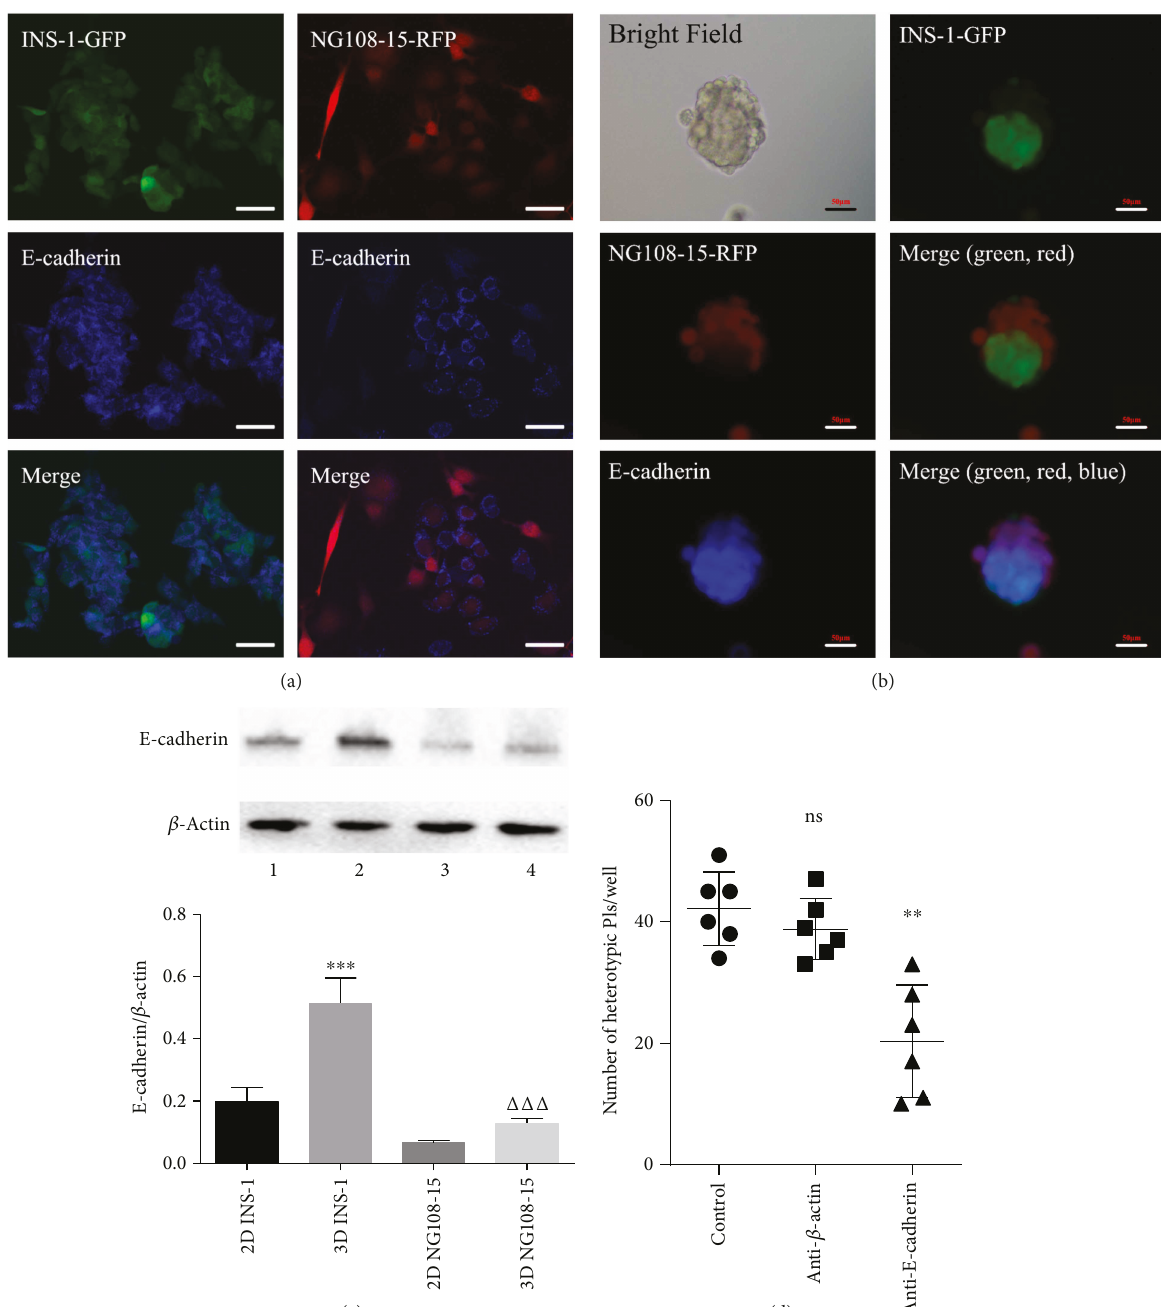
Figure 6: E-cadherin plays a key role in heterotypic pseudoislet formation. (a) E-cadherin was detected in cell climbing slices by indirect immuno fl uorescence (40x). (b) E-cadherin was detected in heterotypic pseudoislets by indirect immuno fl uorescence (20x). (a and b) Red: NG108-15 cells, green: INS-1 cells, and blue: E-cadherin. Scale bars: 50 μ m. (c) E-cadherin was detected in INS-1 and NG108-15 cells by Western blot. Lane 1: 2D-cultured INS-1 cells, lane 2: 3D-cultured INS-1 cells, lane 3: 2D-cultured NG108-15 cells, and lane 4: 3D-cultured NG108-15 cells. ∗∗∗ p < 0 001 versus 2D INS-1 group and ΔΔΔ p < 0 001 versus 2D NG108-15 group, n = 4 . (d) Number of heterotypic pseudoislets formed per well. INS-1 and NG108-15 cells were seeded into 96-well ultra-low attachment plates and maintained in coculture medium (control) with or without E-cadherin antibody or β actin antibody for 24 hours. ns versus control group. ∗∗ p < 0 01 versus anti- β -actin group, n = 6